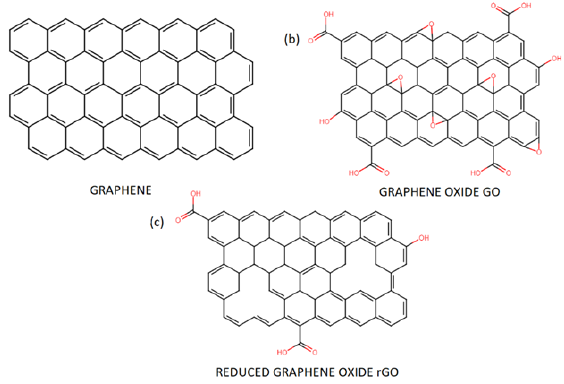
Figure 2. Chemical structure of pristine graphene ( a ) and its derivatives: graphene oxide GO ( b ) and reduced graphene oxide rGO ( c ).